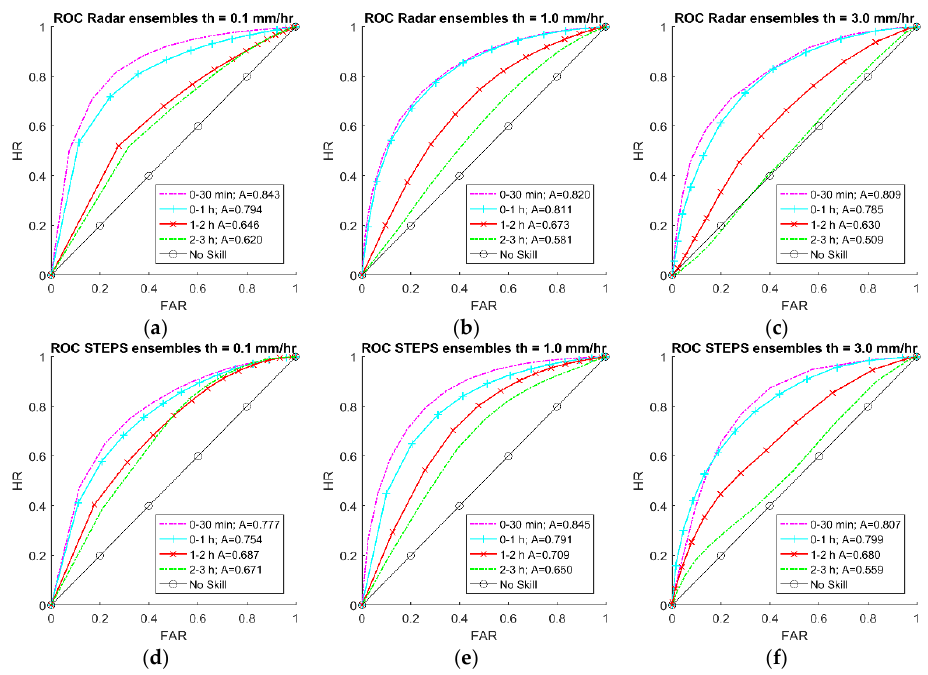
Figure 6. ROC curves for radar and STEPS ensembles for event on 4 October 2008 starting at 15:00 for Radar ensembles and rainfall thresholds (th) equal to 0.1 mm/h ( a ), 1.0 mm/h ( b ) and 3.0 mm/h ( c ). and STEPS ensembles and rainfall thresholds equal to 0.1 mm/h ( d ), 1.0 mm/h ( e ) and 3.0 mm/h ( f ).